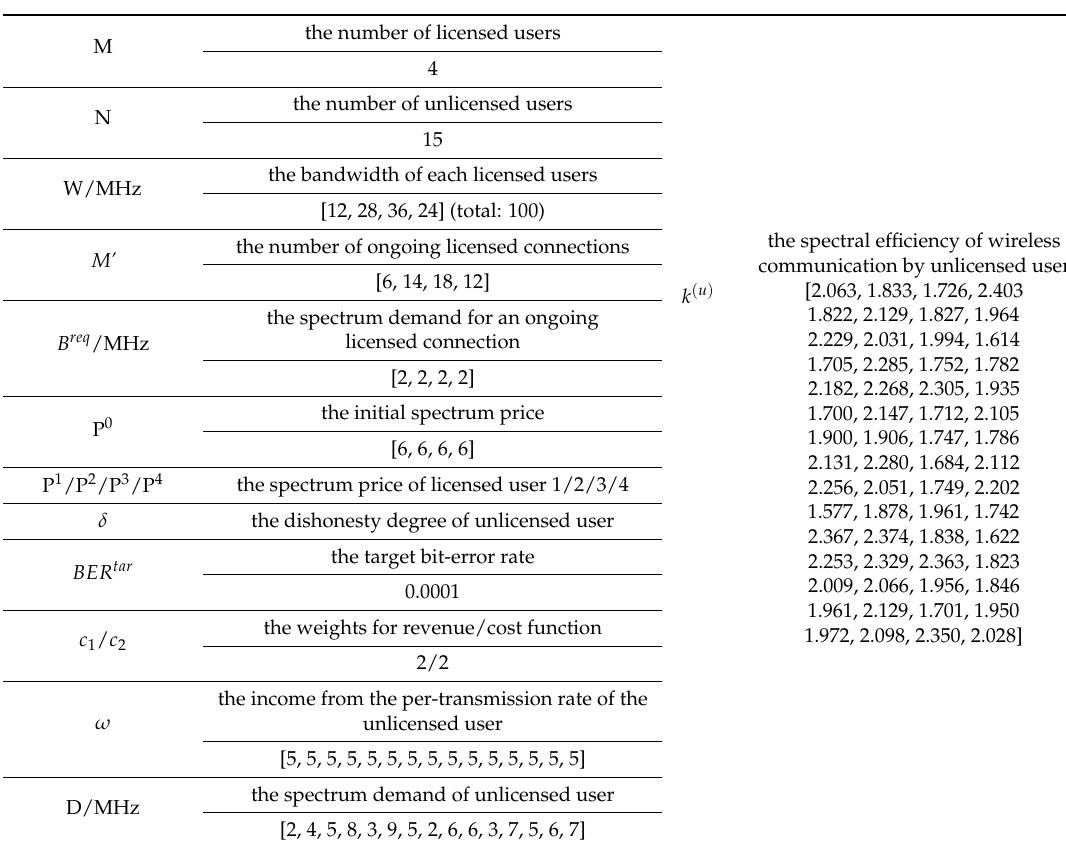
Table 2. Parameter